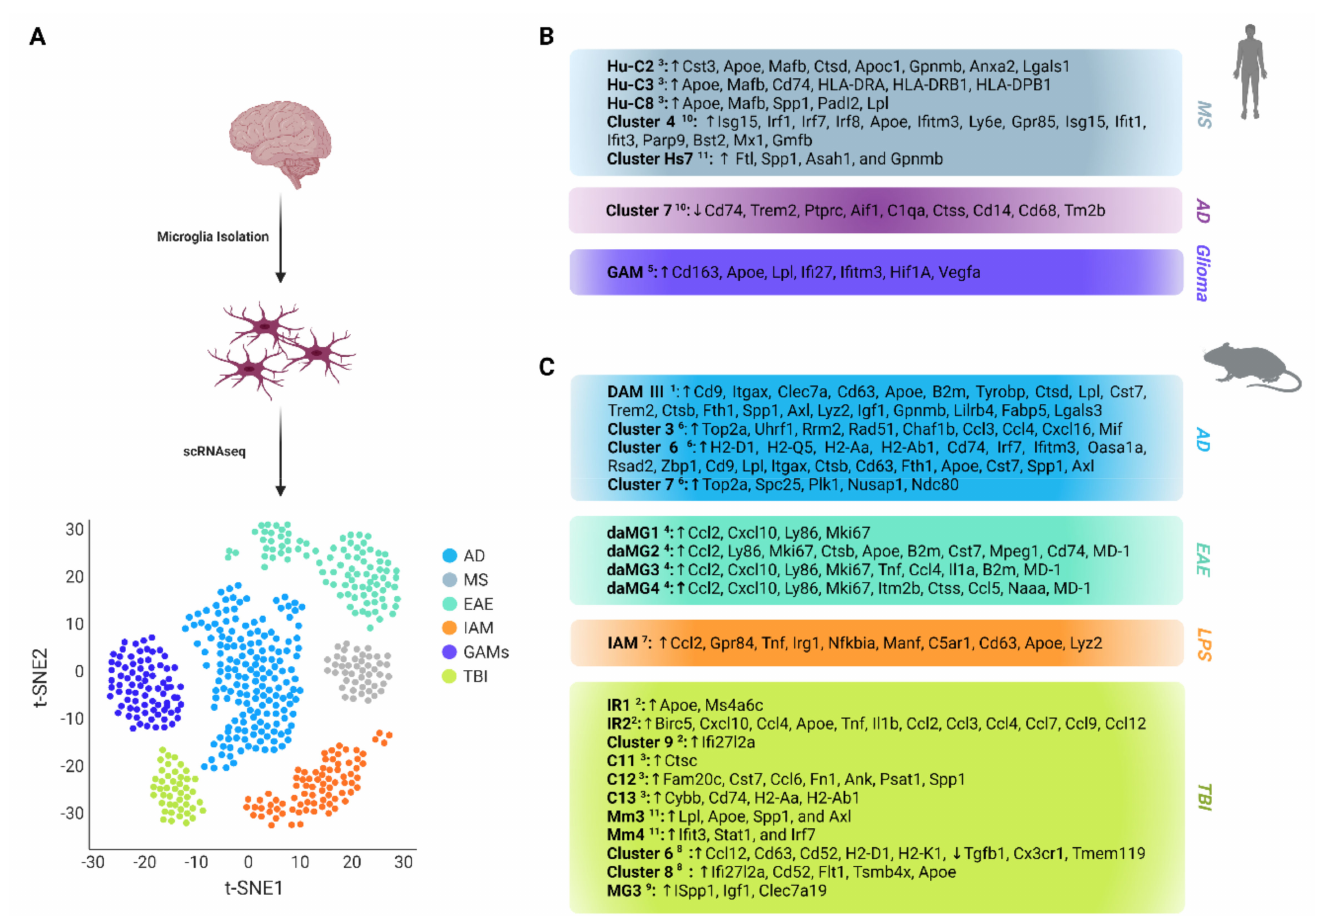
Figure 1. Schematic overview of the most distinct disease-associated microglial populations and their transcriptomic signatures revealed through transcriptional profiling of murine and human microglia using single-cell RNA sequencing. ( A ) Schematic representation of research process for molecular classification of microglial subpopulations. ( B ) Most regulated human disease-associated microglial populations and their transcriptomic signatures. ( C ) Most regulated mouse disease-associated mi- croglial populations and their transcriptomic signatures. Microglial subsets are represented with superscript numbers as described in the studies of 1 Keren-Shaul et al. [14], 2 Hammond et al.